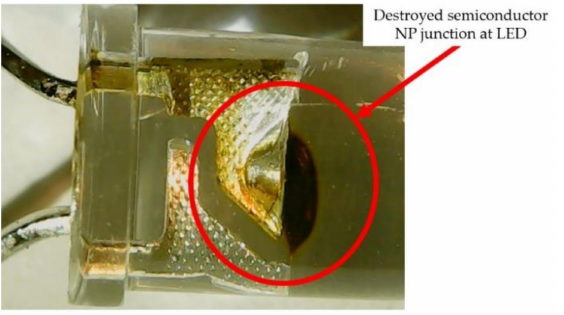
Figure 17. Detailed view of the damaged NP semiconductor structure with LED. In addition, the electronic circuit heated up excessively during the EMP. Figure 18 shows the temperature profile of a heated electronic circuit that was exposed to the EMP at a distance from the source (magnetron) of 1.1 m for 2 s. The IC NE555P is marked by the green frame.